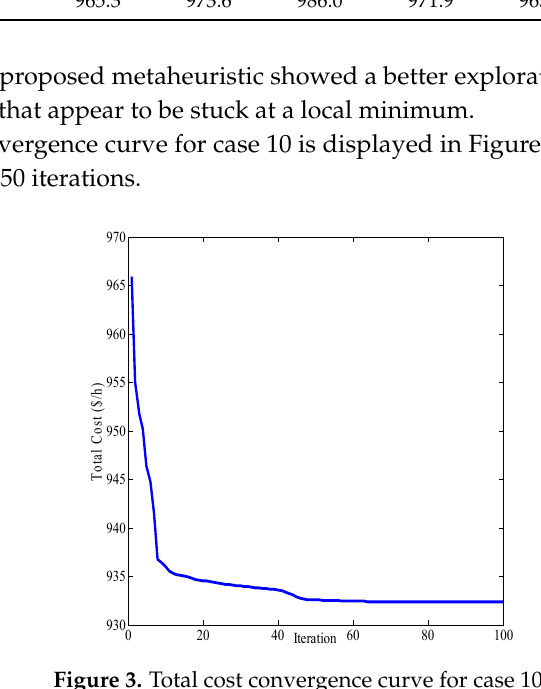
Figure 3. Total cost convergence curve for case 10.